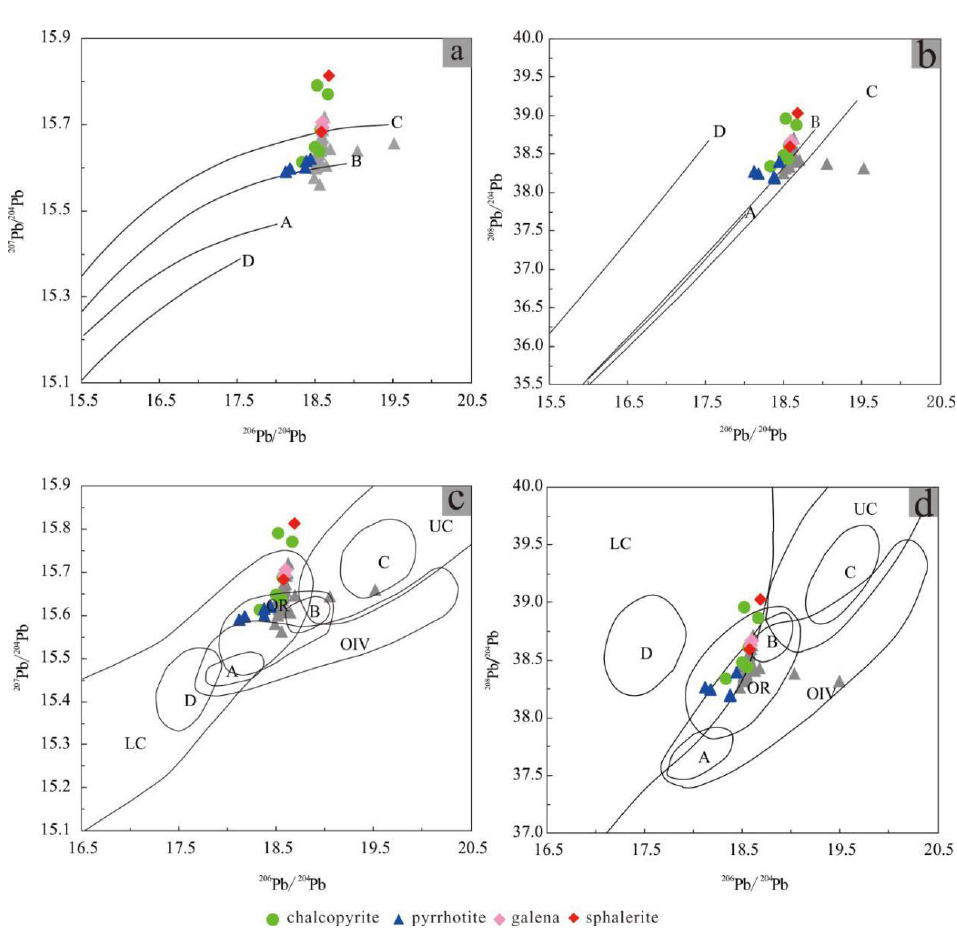
Figure 12. ( a , b ) Pb-isotope tectonic model diagram [89]; and ( c , d ) tectonic environment discrimination diagram [89] for the Hutouya deposit (LC–lower crust; UC–upper crust; OIV–Ocean